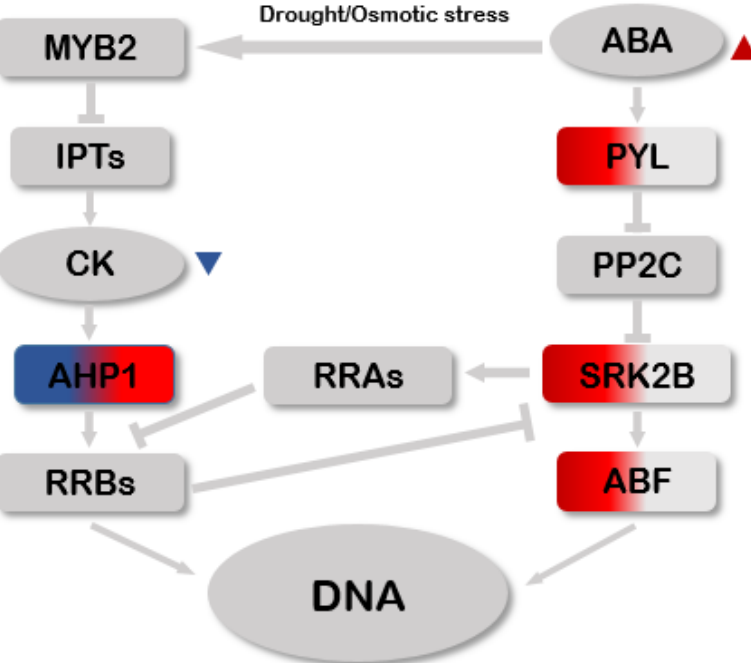
Figure 9. Crosstalk between ABA and CK signaling pathways. The left half of the protein (cube) represents R3/R1, and the right half represents R4/R3. Blue represents significantly down-regulated (<0.67), red represents significantly up-regulated (>1.5), and gray represents unidentified or non- DEPs. The predicted content changes of CK and ABA are marked by triangles.